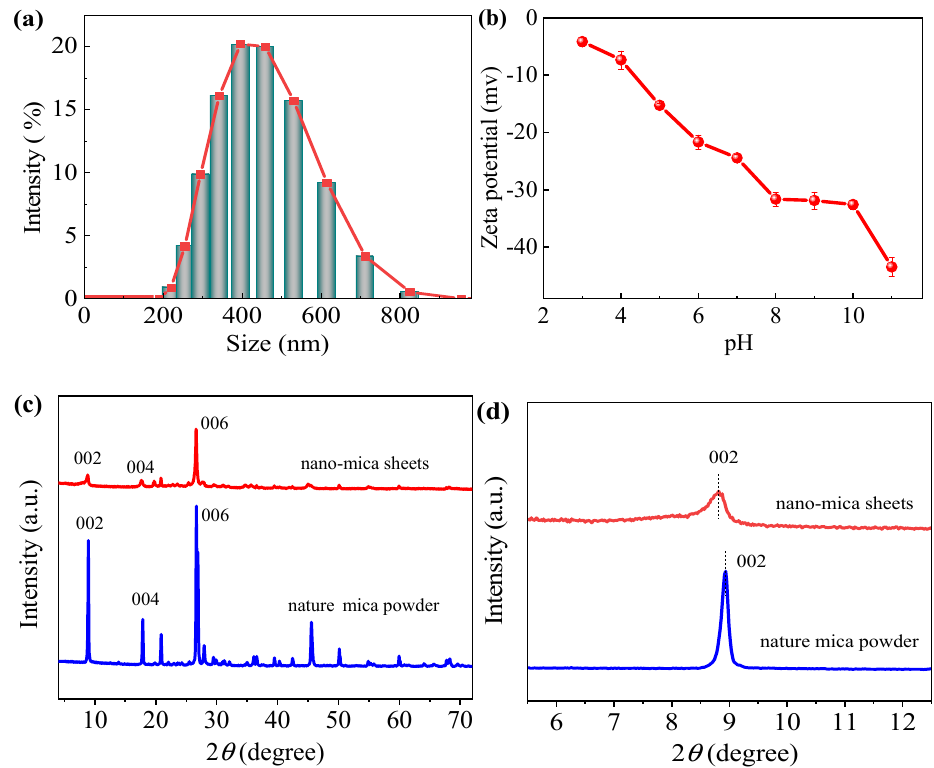
Figure 2. ( a ) The particle size distribution of 2D nano-mica sheet, ( b ) The zeta potential of 2D nano- mica sheet at different pH, ( c , d ) XRD spectra of nature mica powder and 2D nano-mica